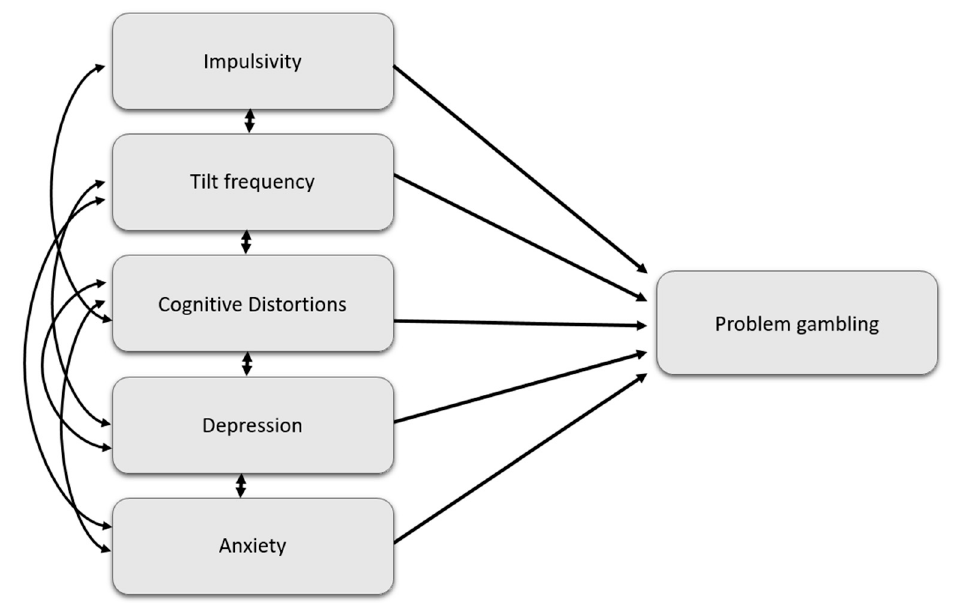
Figure 1. Theoretical-based model predicting problem gambling in the online poker population. For clarity, only the latent variables are shown in the figure.